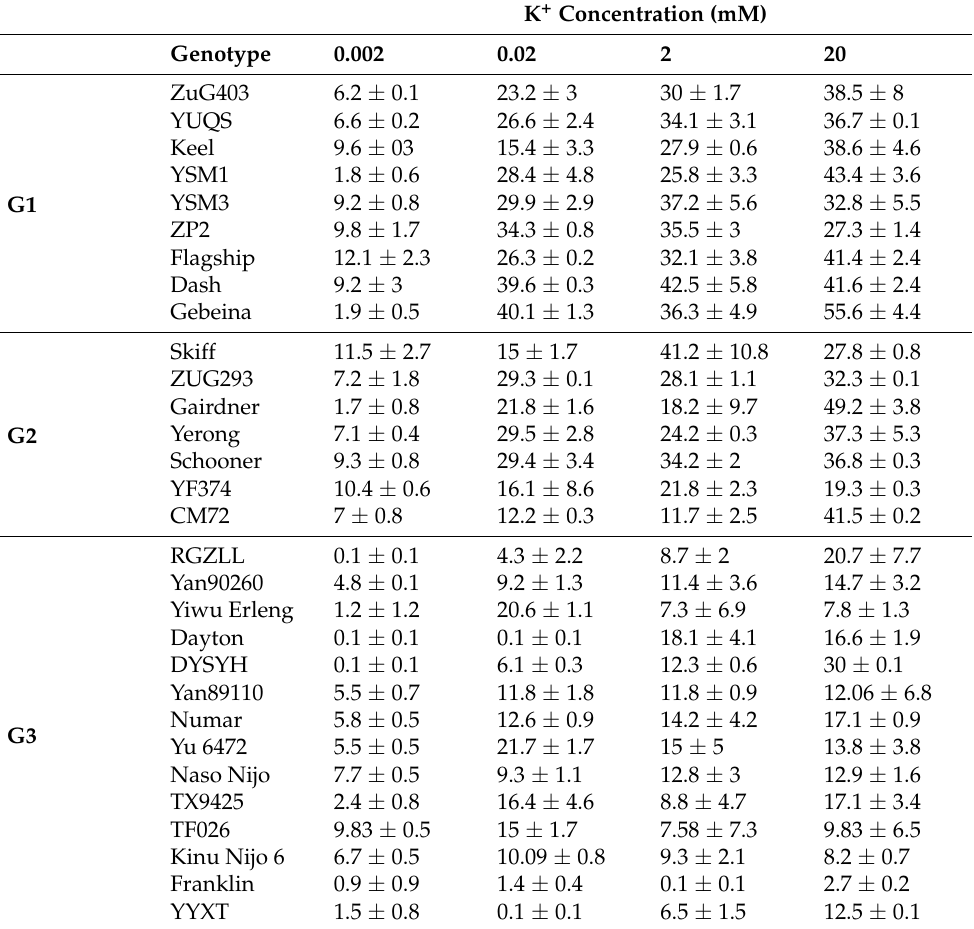
Table 5. Genotypic variation in the grain numbers of barley genotypes under different concentration of K + supply. Values are mean ± SE ( n = 6) and G represents different groups of genotypes. Genotypes have been divided into three group G1, G2 and G3 according to cluster analysis (see Section 3.1 and Figure